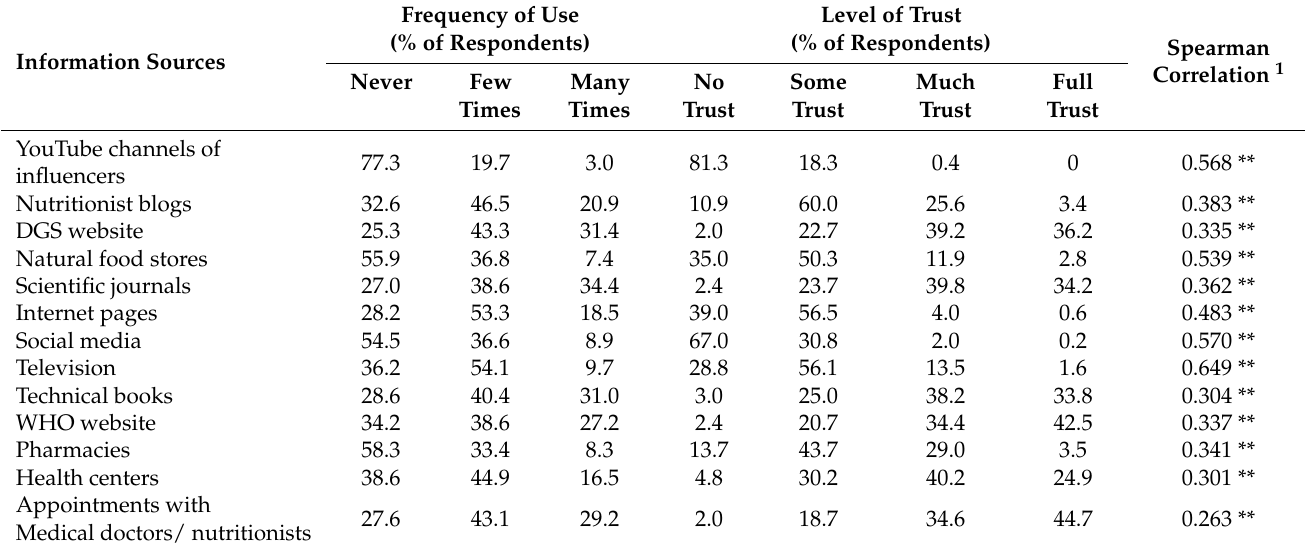
Table 5. Expressed opinions and association between the frequency of utilization and level of trust in the information sources. Frequency of Use Information Sources